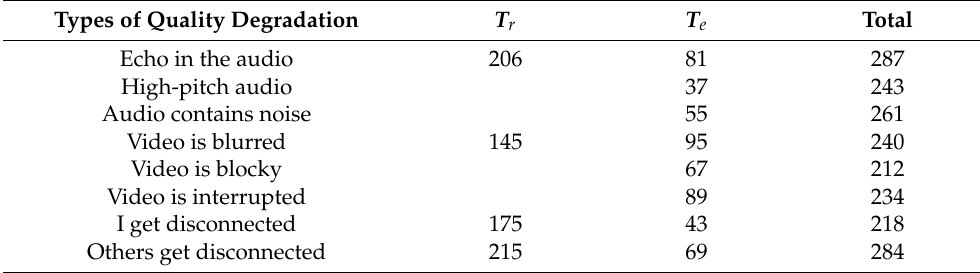
Table 3. The size of the training ( T r ) and testing ( T e ) sets per each degradation. Types of Quality Degradation T